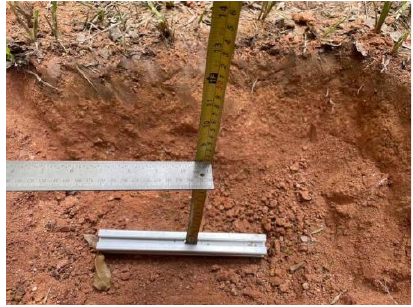
Figure 9. Field electromagnetic wave velocity measurement.